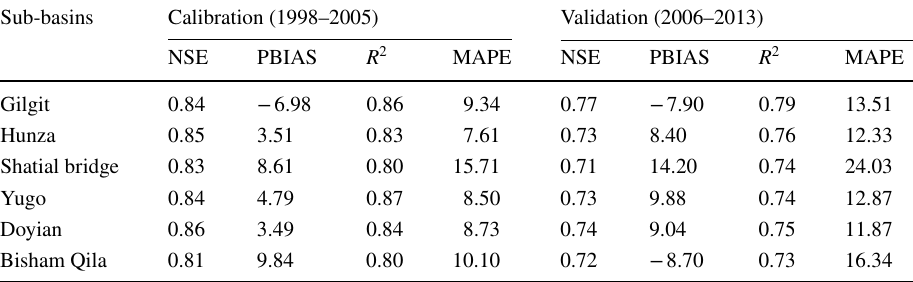
Table 5 Performance evaluation of SWAT model during calibration and validation period using NSE, PBIAS, R 2 , and MAPE statistical